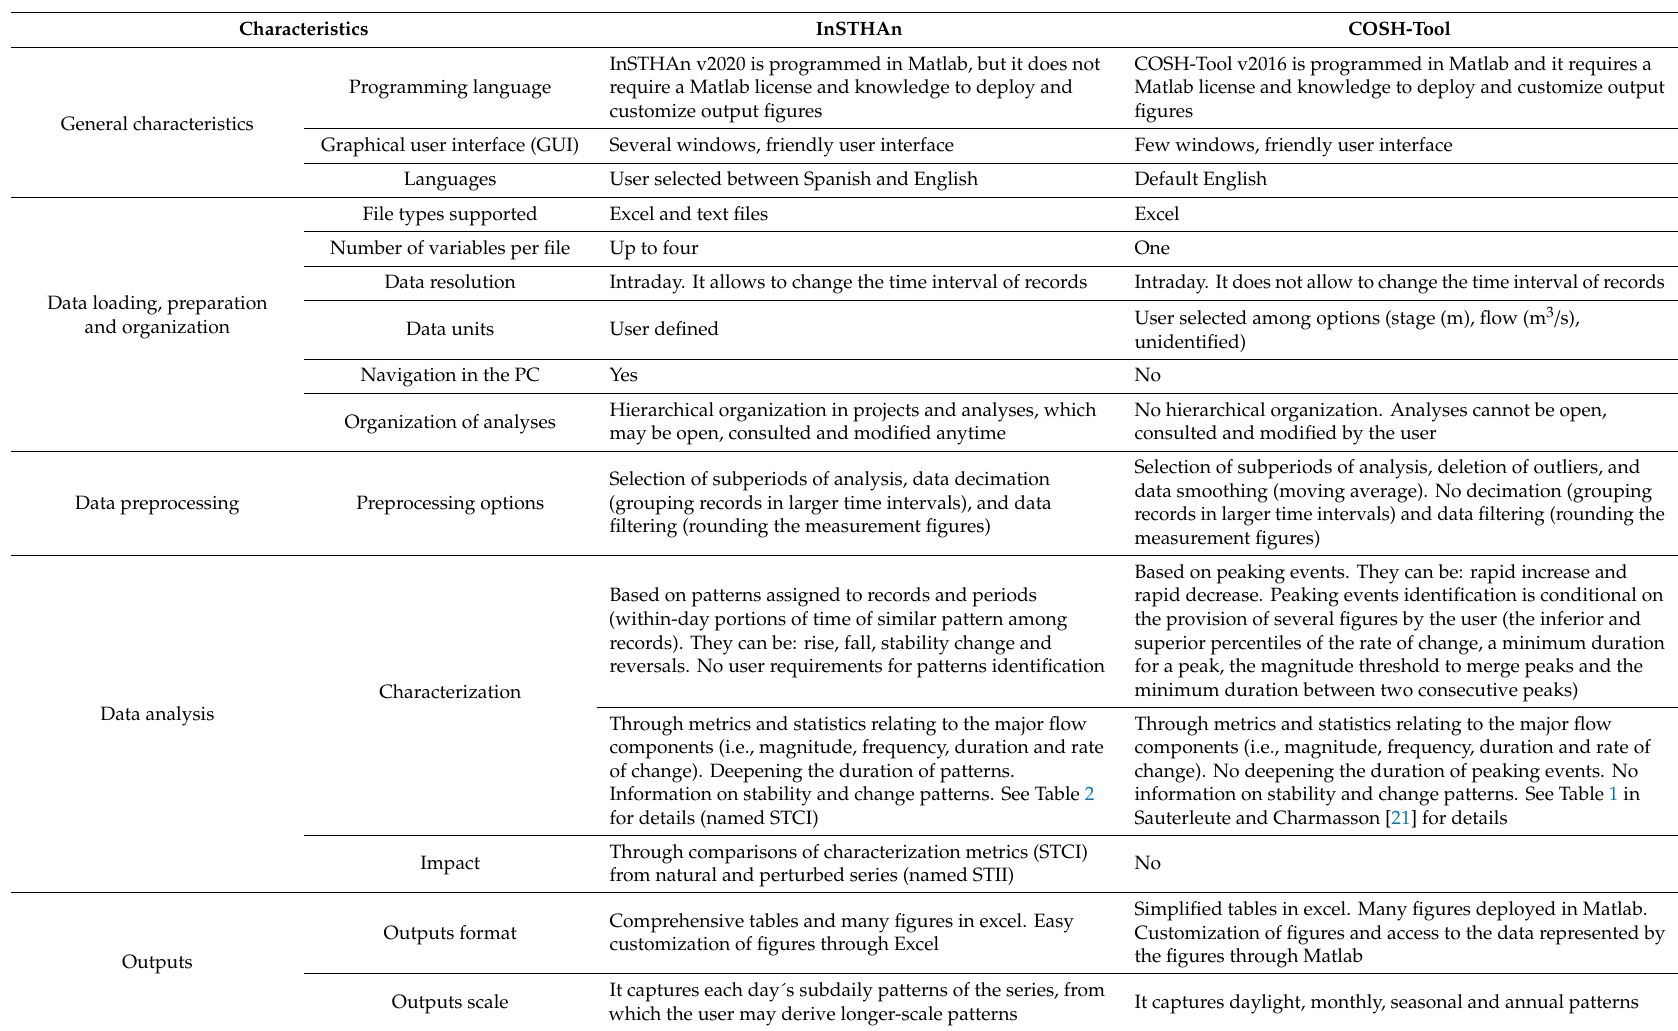
Table 3. Comparison of the tools used in this article: InSTHAn (v2020) and COSH-Tool